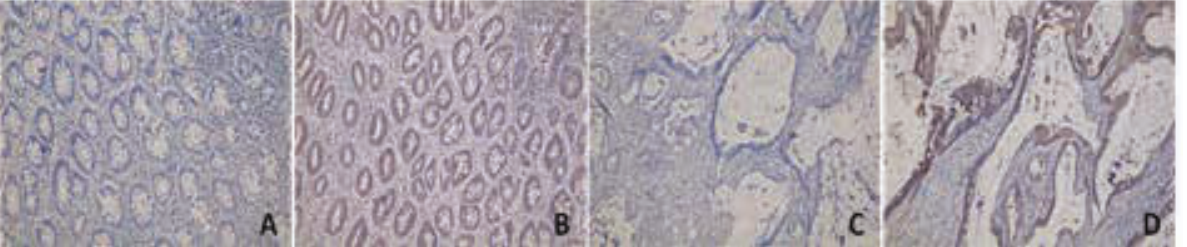
Figure 1: Galectin-3 expression in colorectal cancer tissue and normal intestinal tissues by immunohistochemistry (A: galectin-3 negative expression in normal intestinal tissues, × 200; B: galectin-3 positive expression in normal intestinal tissues, × 200; C: galectin-3 negative expression in colorectal cancer tissues, × 400; D: galectin-3 positive expression in colorectal cancer tissues, × Table 1: The association between Galectin-3 protein expression and clinical pathological characteristics